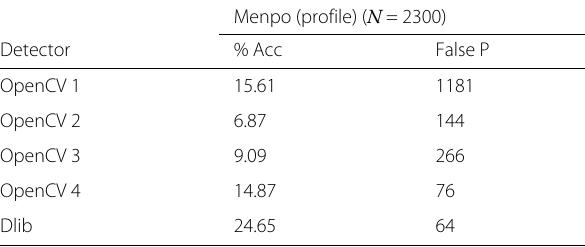
Table 3 ‘Off-the-shelf’ profile face detector performance Menpo (profile) ( N =